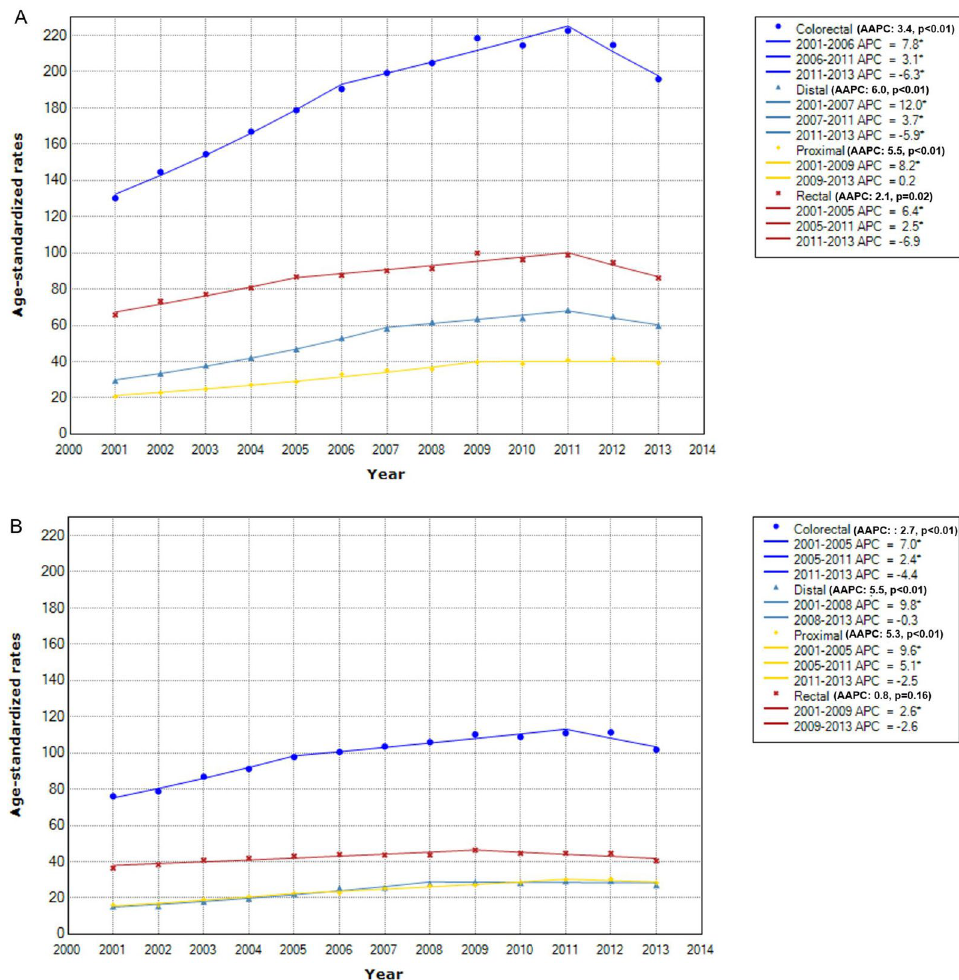
Figure 3. Time trend of late-onset colorectal cancer incidence rates by sex and anatomical subsite. *Indicates that APC is significantly different from zero at the alpha = 0.05 level. ( A ) In men. ( B ) In